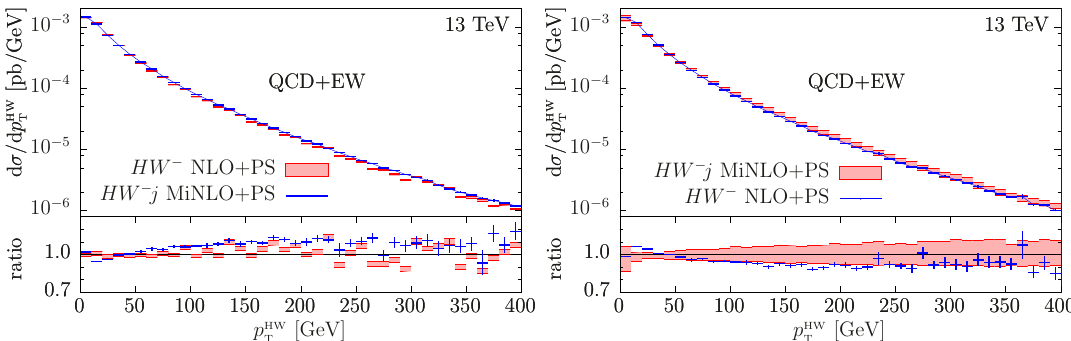
Figure 27. Same comparison as in (cid:12)gure 26, in a wider p HW